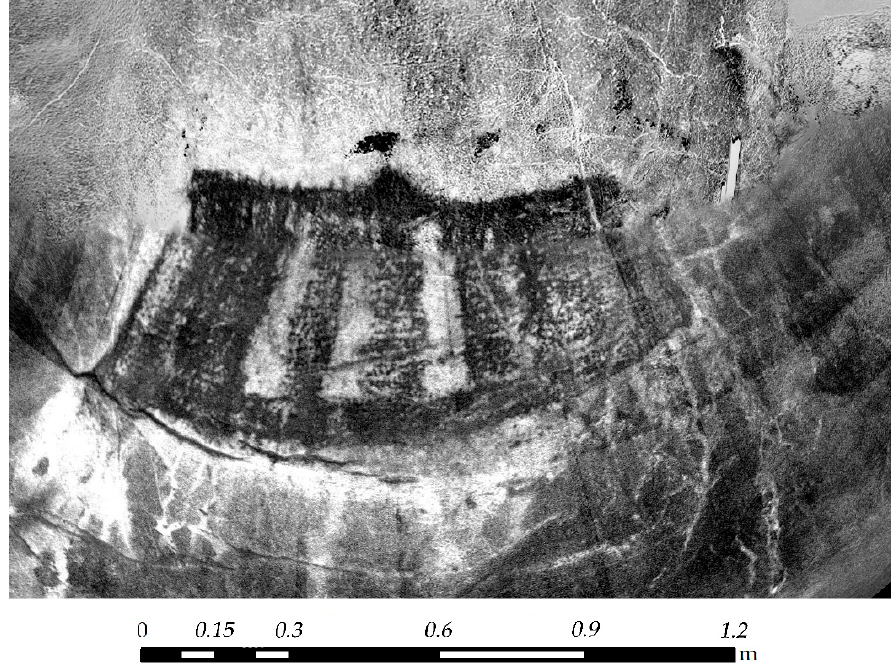
Figure 9. 2nd PCA component showing the recovery of figure contours as described in [3]. 4. Extraction of underlying pigments under the calcic crust and the ochre pigment help reconstruct the painting sequence: in the image on the left you can see the legs of a goat and on the right the head of a female deer. (Figure 10).